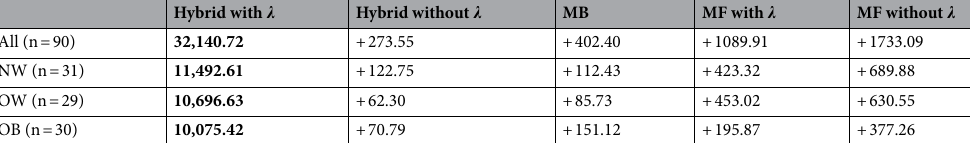
Table 3. Model comparison. Values reflect Bayesian Information Criterion (BIC) scores. Values in bold reflect the winning model when comparing the models across all participants, as well as in each group separately. Non-Bold scores reflect the difference with regard to the winning ‘full’ hybrid model with (cid:31) . NW normal- weight, OW overweight, OB obese, MB model-based, MF